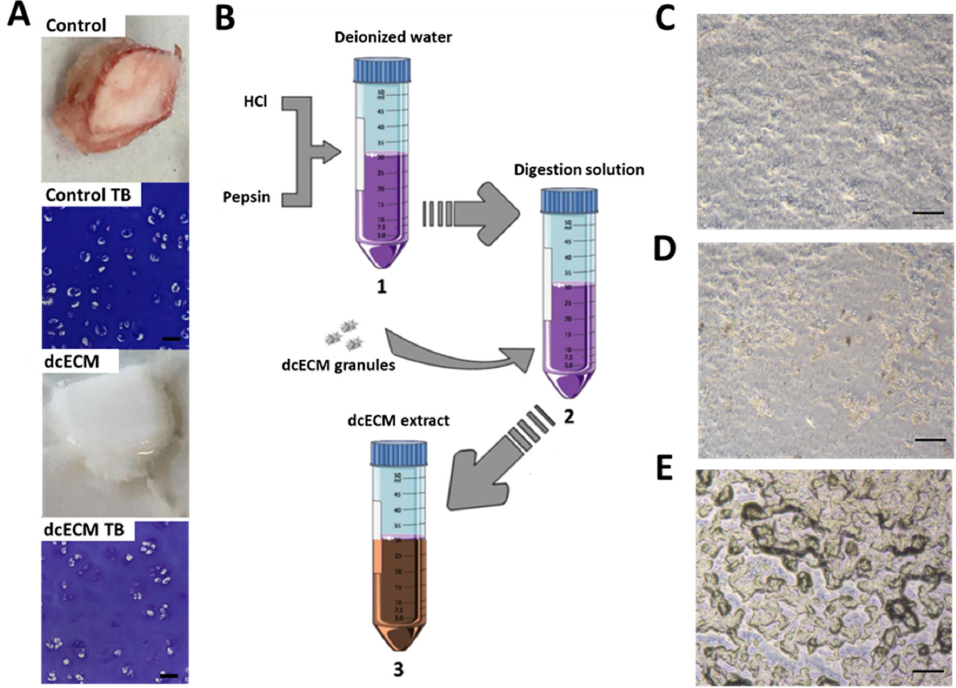
Figure 1. Methodology to create dcECM extract and tissue culture surface coating. ( A ) Representative macroscopic and Toluidine Blue (TB) image of control hypertrophic costal cartilage and dcECM (decellularised costal cartilage extracellular matrix); Scale Bar = 50 µm. ( B ) Methodology used to create dcECM extract: (1) Digestion solution (1 mg/mL Pepsin in 0.01 M HCL); (2) Sterile freeze-dried dcECM granules are digested at a concentration of 10 mg/mL; (3) extract after 96 h. ( C ) Brightfield images of tissue culture plastic coated with non-sterilised, ( D ) UV sterilised, and ( E ) autoclaved dcECM extract; Scale Bar = 100 µ